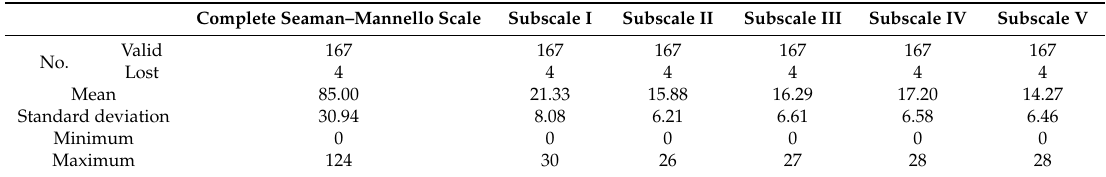
Table 2. Grouped descriptive statistics of the Seaman–Mannello